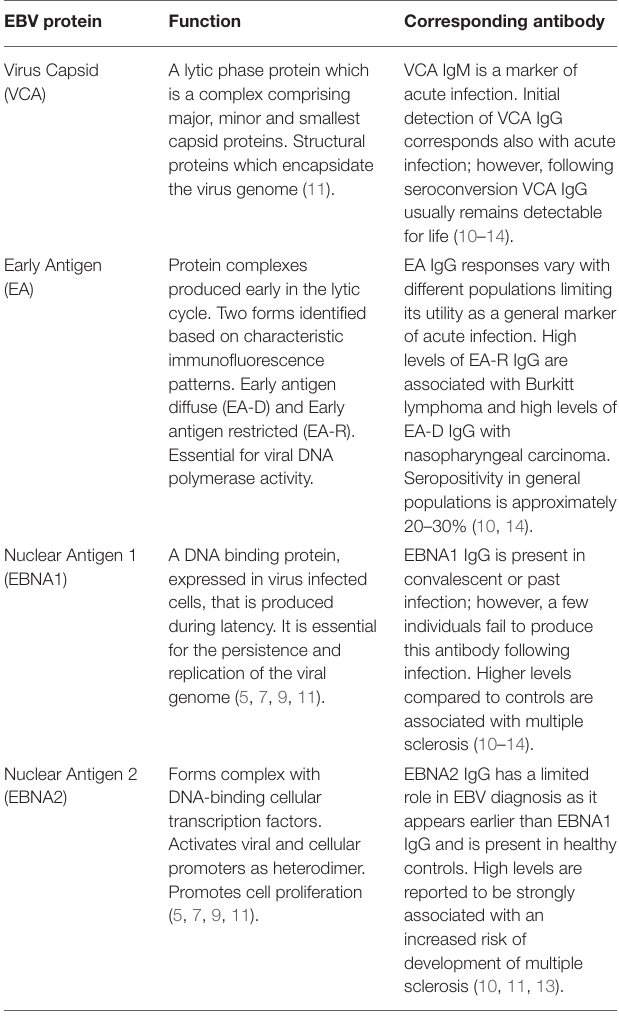
TABLE 1 | EBV proteins and associated antibodies commonly used as infection markers and in investigations of associations with multiple sclerosis a . EBV